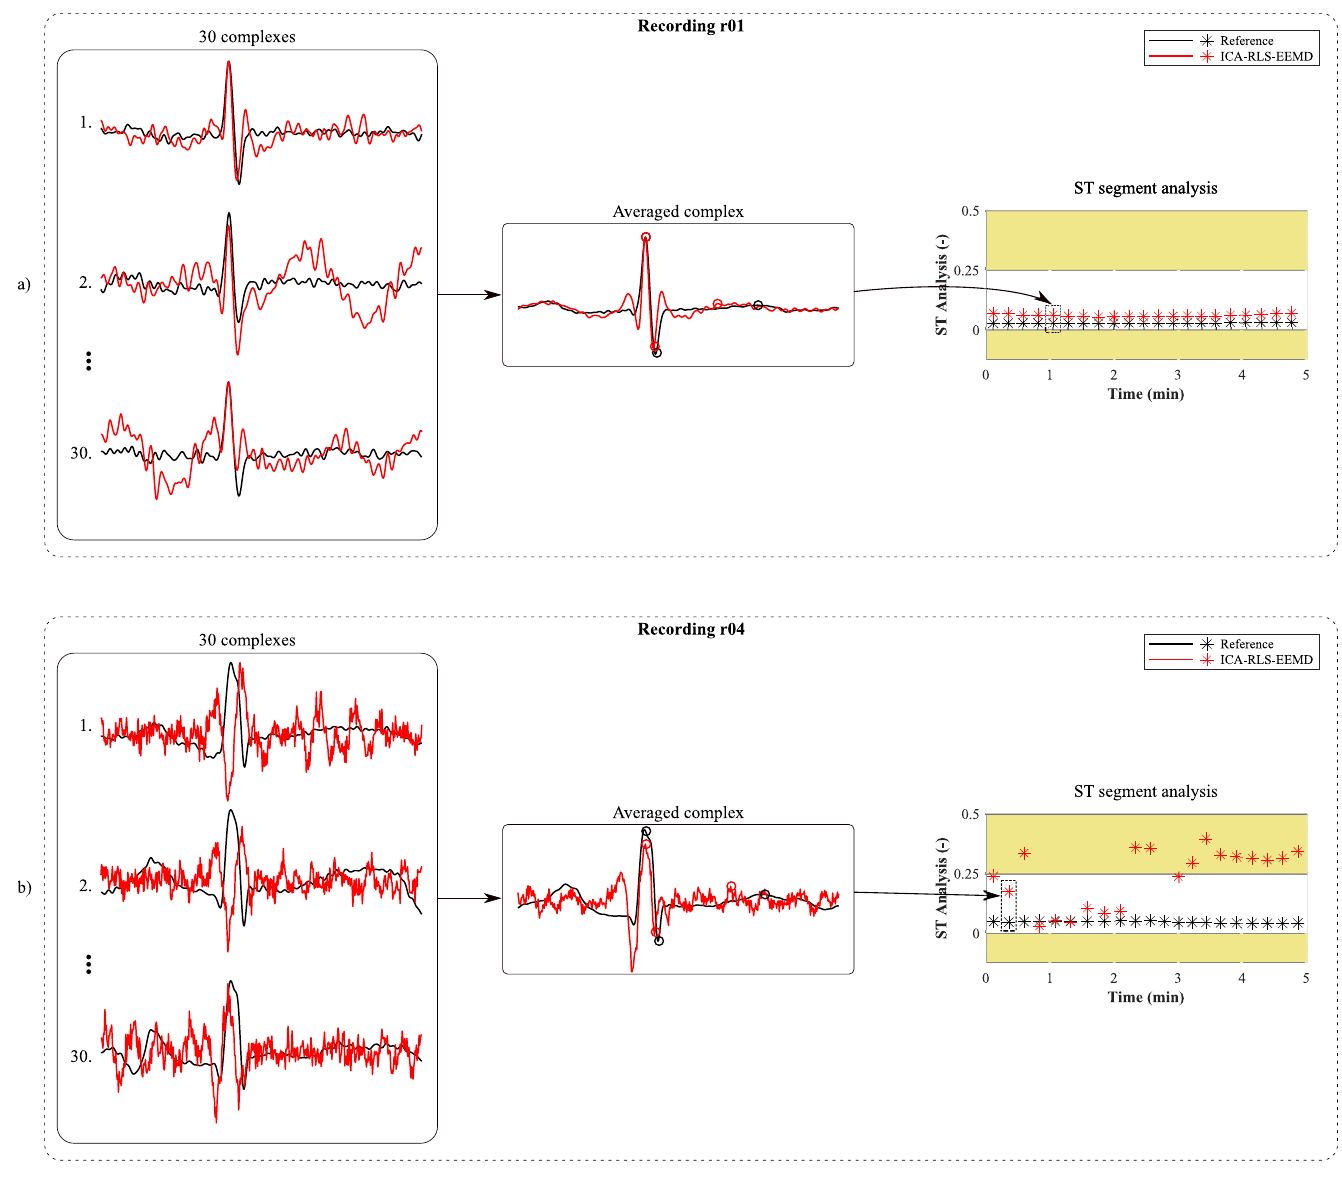
Fig 6. Averaging of the fQRS complexes and T/QRS calculation of a) recording r01, which achieved high accuracy; b) for recording r04, which achieved poor